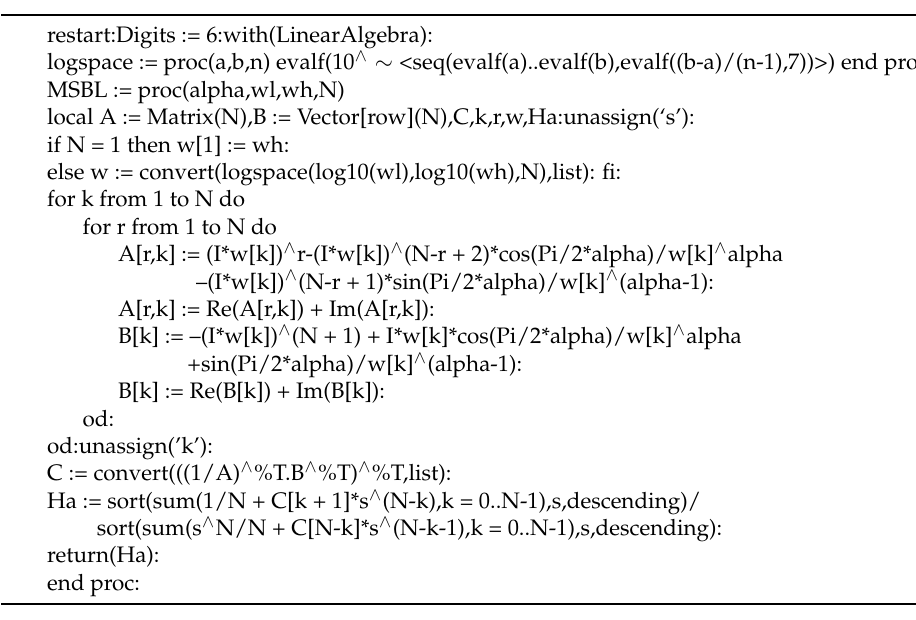
Table 14. Maple 18 code of MSBL